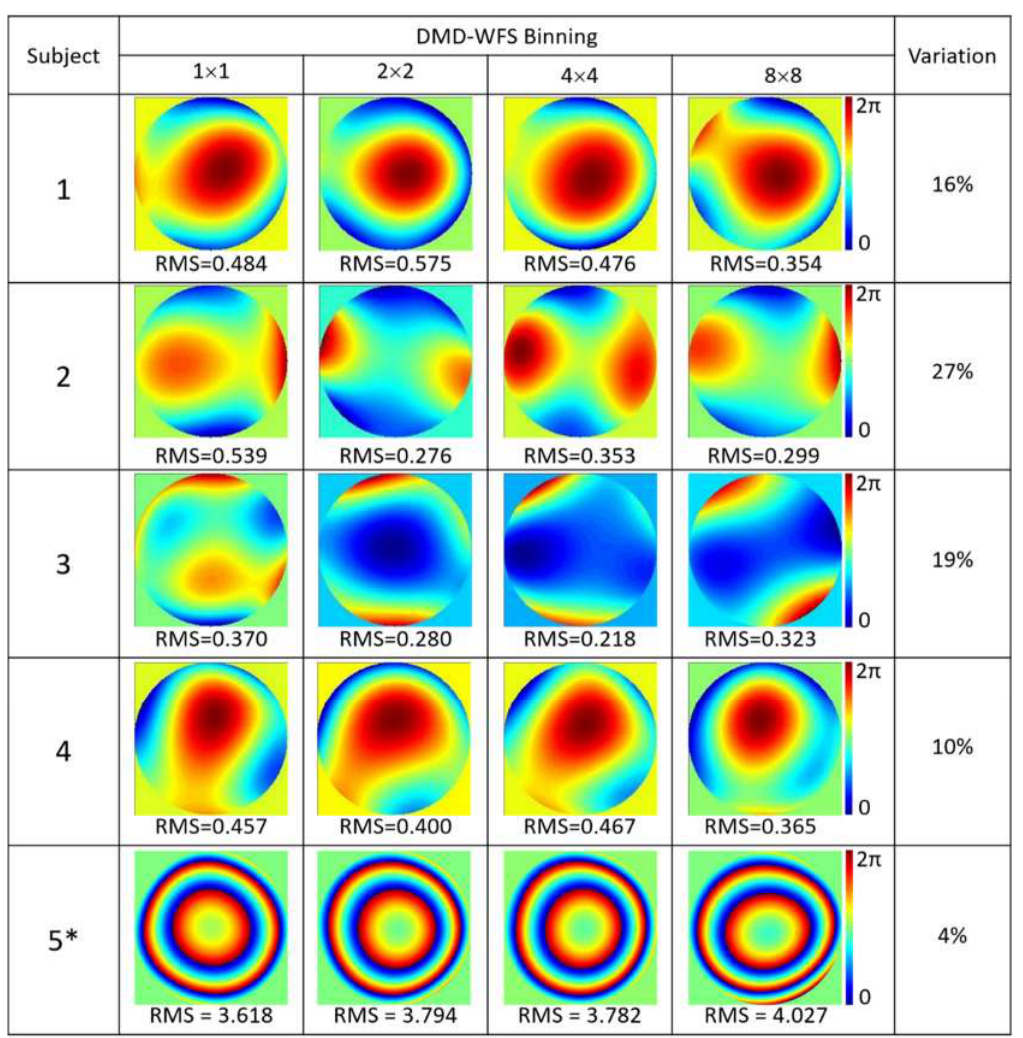
Figure 5. Ocular aberrations measured with the DMD-WFS with 5 × 5 sampling density for four subjects with normal vision and one myopic subject (−7D), marked with an asterisk (*), using DMD cell with at least 50% of its area illuminated. Quantification of wavefronts are presented as RMS values given in μm.